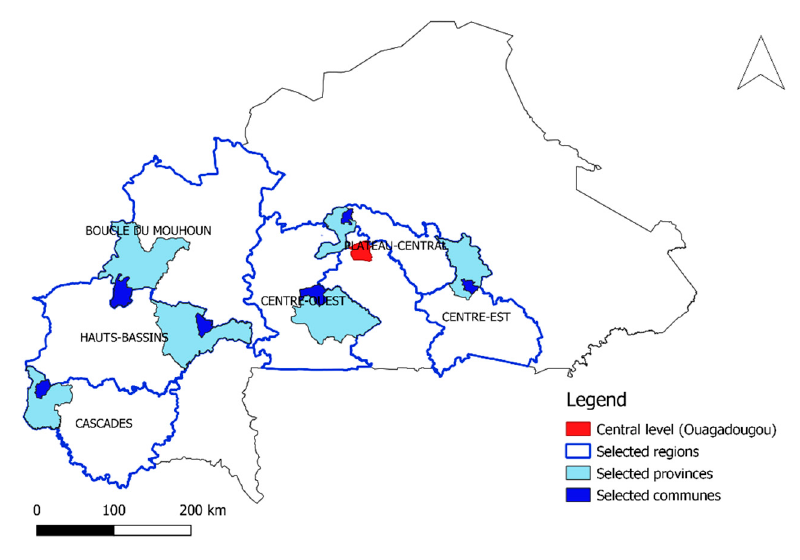
Figure 1. Map of Burkina Faso with the study areas (mapped by the first author using QGIS).